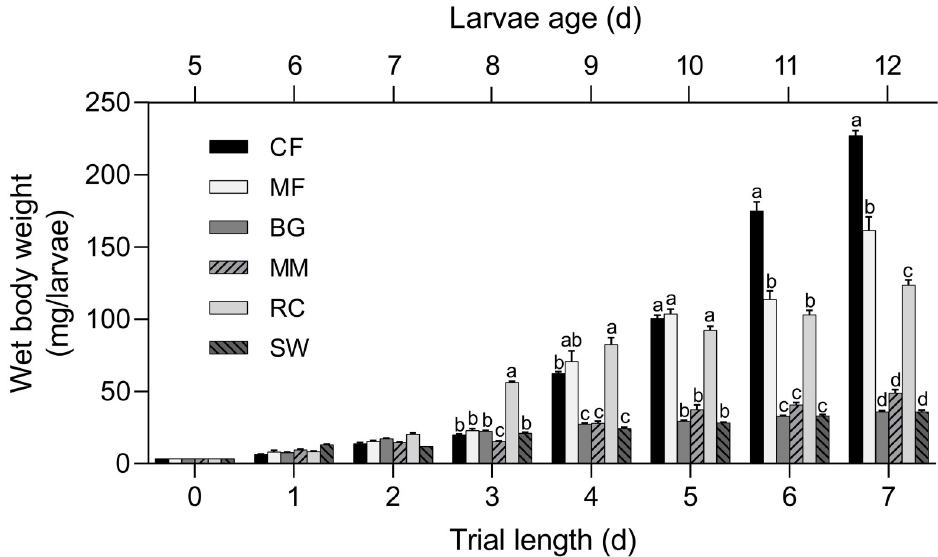
Fig 1. Mean ± standard error (n = 3) of individual wet body weight (mg) of black soldier fly larvae over time reared on six different rearing substrates: Chicken feed (CF), mixed feed (MF), brewer’s spent grain (BG), mitigation mussels (MM), rapeseed cake (RC), and shrimp waste (SW). Dissimilar lower case superscript letters represent significant differences (p < 0.05) between means within the same time